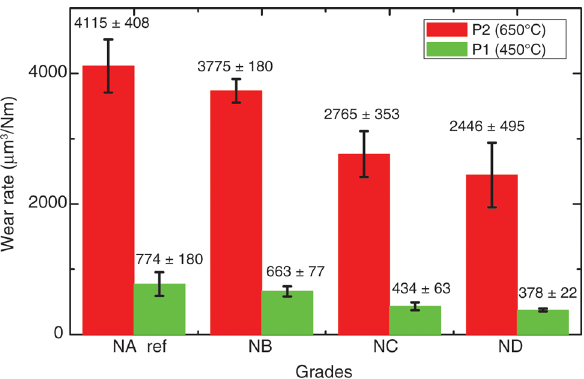
Figure 8: Comparison of the wear rate of different grades cermets according to the reference grade (NA) for the two tem- perature P1(450°C) and P2(650°C) for a distance travelled (5000 m).